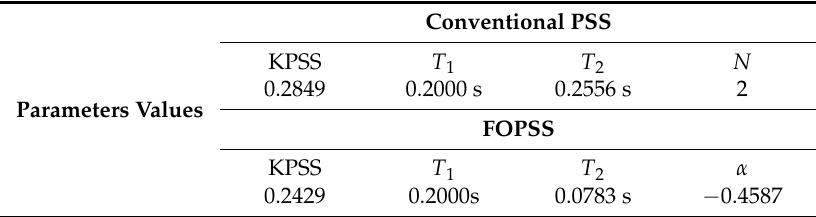
Table 4. Parameters values for the designed FOPSS and Conventional